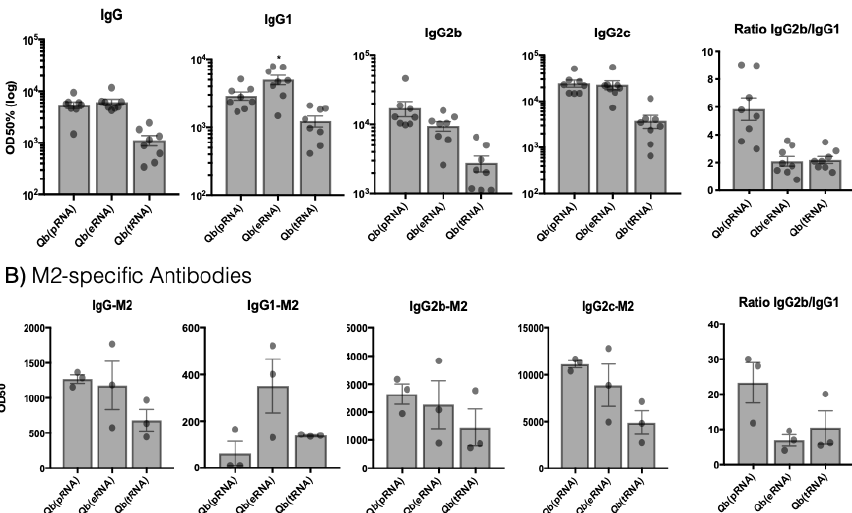
Figure 2. Total IgG and subtypes and IgG2/IgG1 ratio are influenced by the type of RNA packaged by virus-like particles (VLPs). IgG, IgG1, IgG2b and IgG2c 10 days after s.c. immunisation with 50 μg of VLP. Qβ(eRNA)-M2e induces significantly higher levels of antigen-specific IgG1 compared to the two other vaccines (p > 0.03) against VLP and M2. Ratios of IgG2b:IgG1 are represented as isotype geometric mean titres. A) VLP-specific antibodies. Mean + SEM n = 8 mice per group B) M2-specific antibodies. Mean + SEM n = 3 mice per group. OD50 with titres defined as those dilutions that reached half the maximal OD observed for the assay. Mean ratio of IgG2b/IgG1 + SEM. Results are representative of three independent experiments.